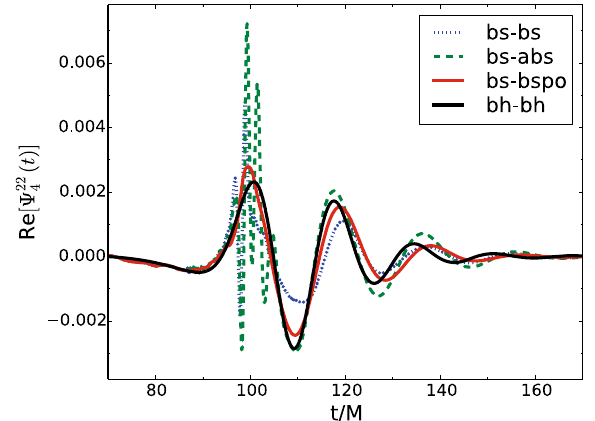
Fig. 23 Gravitational waves, represented by the l = m = 2 mode of the Newman-Penrose scalar, Ψ 4 , emitted during the head-on collision of two solitonic BSs. For all configurations, the final object is